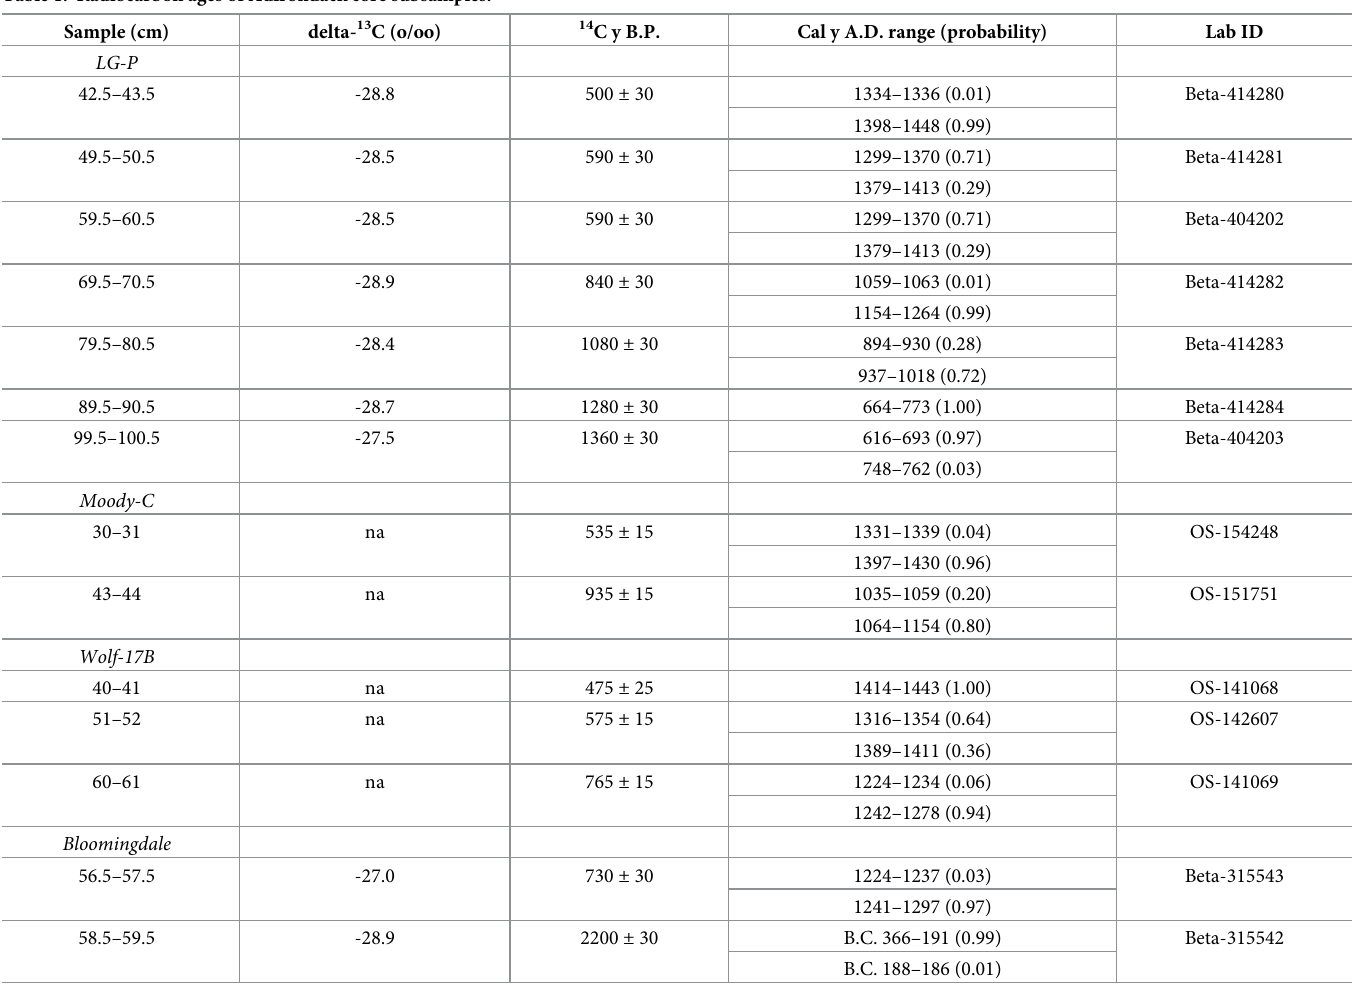
Table 1. Radiocarbon ages of Adirondack core subsamples. Sample